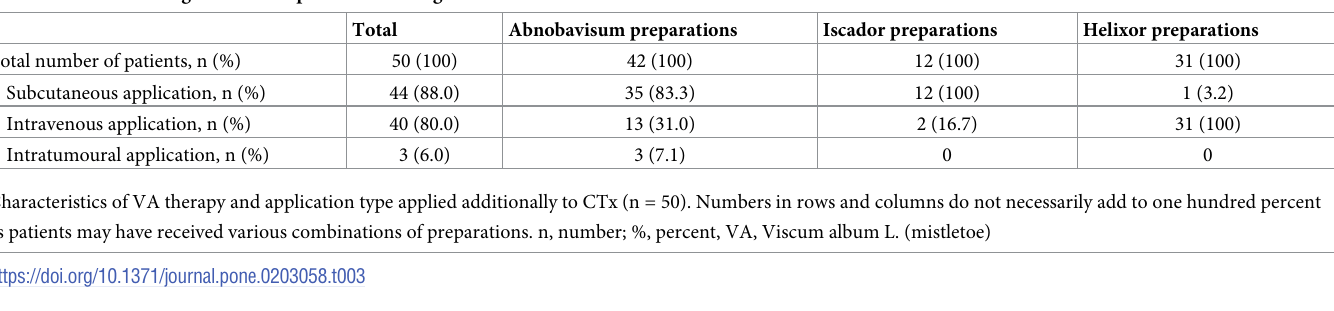
Table 2. Gemcitabine was applied to 11 (7%) patients either as monotherapy or in combination with platinum compounds or vinorelbine at some point. Docetaxel and paclitaxel were the most frequent taxanes (22 patients, 13.9%) and mainly given as monotherapy or in combina- tion with platinum compounds. 24 (15.2%) patients received bisphosphonates, one patient received hormonal therapy, namely bicalutamide, data not shown. As to first-line CTx treat- ment no significant differences were seen between both groups, data not shown. For those patients for whom second-line treatment data was retrieved, no significant differences between both groups were detected, data not shown. In addition to CTx, 50 patients (31.7%) received extracts of VA, see Table 3. The most frequent type of application for mistletoe agents was subcutanous injection in 44 patients (88.0% of all VA patients), followed by off-label intravenous or intratumoral injections in 40 (80%) and 3 (6.0%) patients, respectively. In general, Abnobavisucm extracts were the mistletoe remedies most often prescribed (n = 42), especially for subcutaneous application (n = 35), followed by Helixor reme- dies, mainly used for intravenous application (n = 31) and Iscador preparations (n = 12).